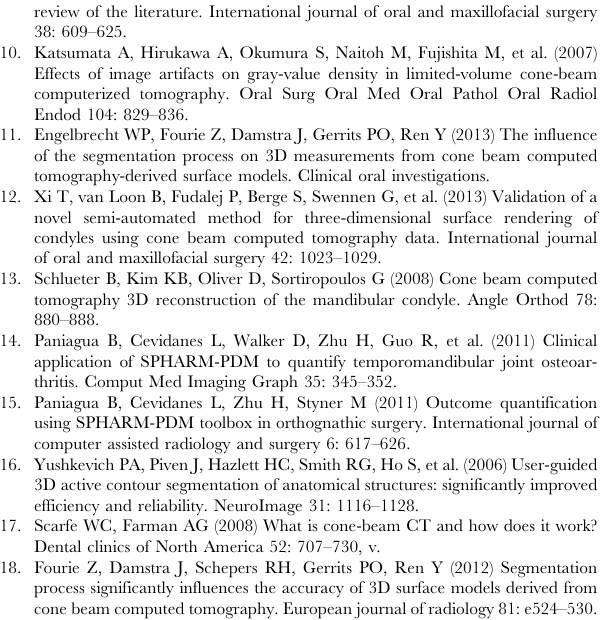
Table S1 Condylar volumes (mm 3 ) obtained by manual segmentation (golden standard), observer 1 (TX) and observer 2 (RS). (XLSX) Table S2 The mean absolute errors (standard devia- tion, percentile, range) in condylar volume (mm 3 ) between the manual segmented condyles and condyles segmented by both observers using the currently described semi-automated segmentation protocol. (XLSX)